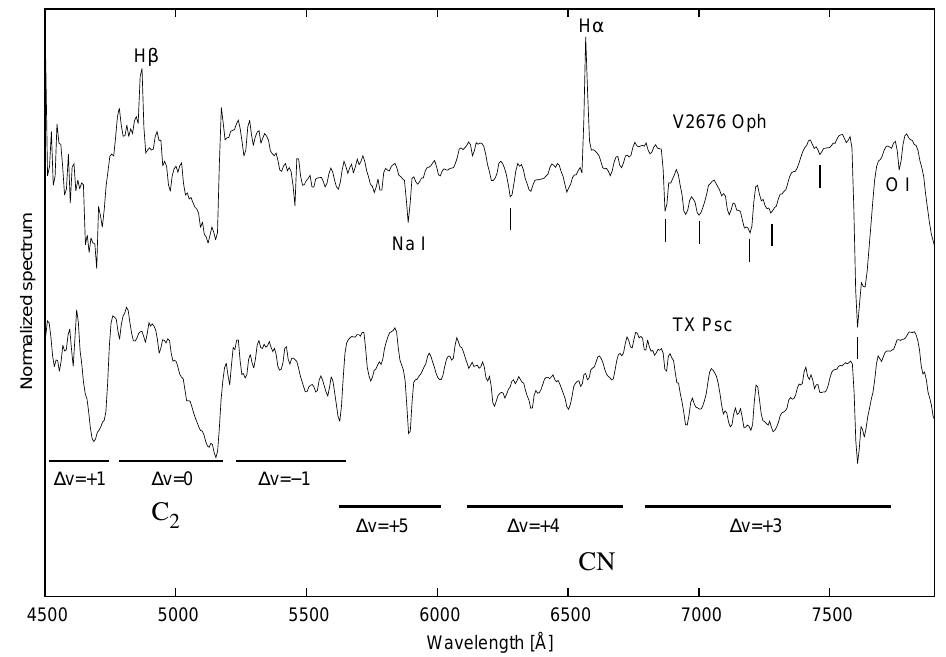
Figure 1: Comparison of the spectrum of V2676 Oph obtained on Apr 8 with that of a typical carbon star, TX Psc. Tick marks indicate telluric absorption